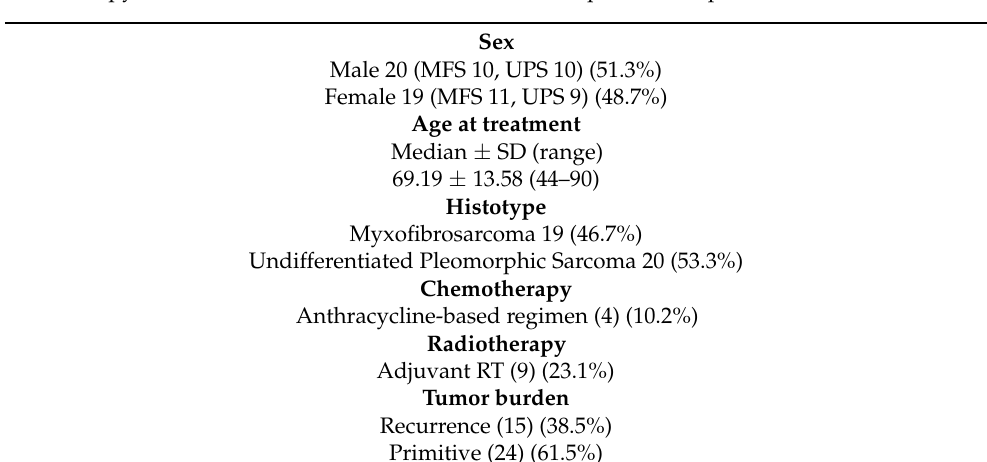
Table 1. Patients’ clinicopathological characteristics. Sex, age at treatment, histotype, chemotherapy, radiotherapy, and tumor burden of enrolled MFS and UPS patients are